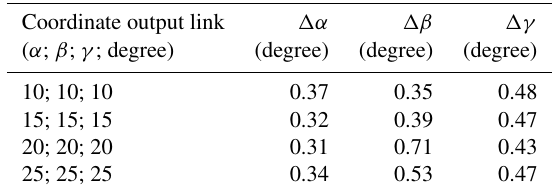
Table 1. Output link angles deviation